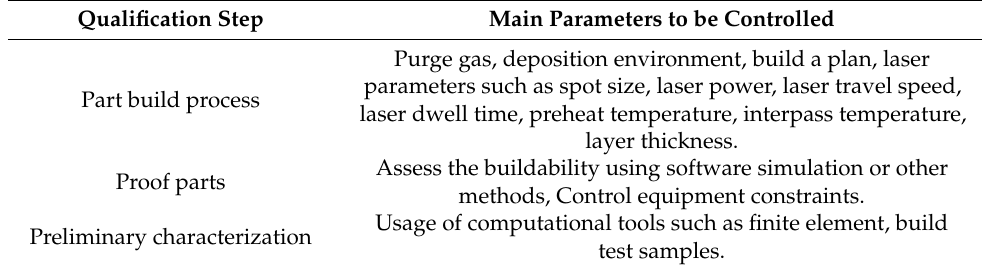
Table 3. Qualification parameters in manufacturing procedure qualification